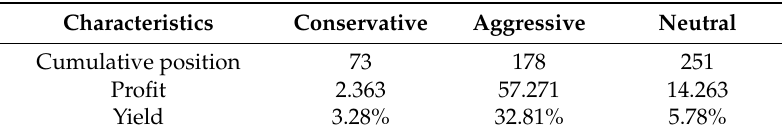
Table 4. Simulation